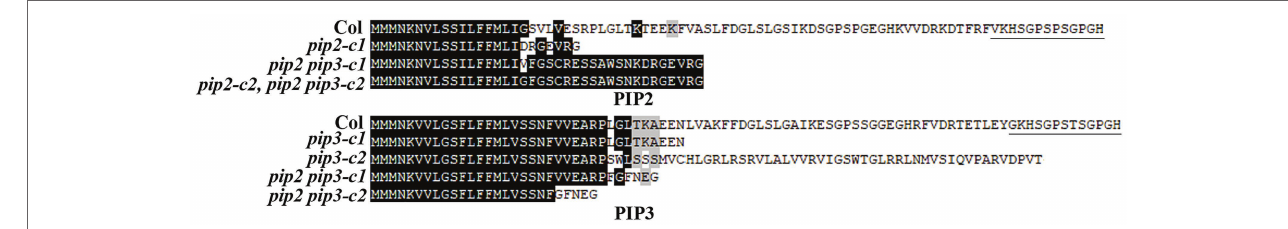
FIGURE 4 | Amino acid alignment of PIP2 and PIP3 in the Col wild type and the pip2 , pip3 and pip2 pip3 mutants. The open-reading frame (ORF) of PIP2 and PIP3 sequences in the pip2 and pip2 pip3 mutants were identified by using ORFfinder (https://www.ncbi.nlm.nih.gov/orffinder/), and corresponding amino acid sequences were used for alignment with the amino acid sequences of PIP2 and PIP3, respectively. Under lines indicate the mature PIP2 and PIP3 peptides.